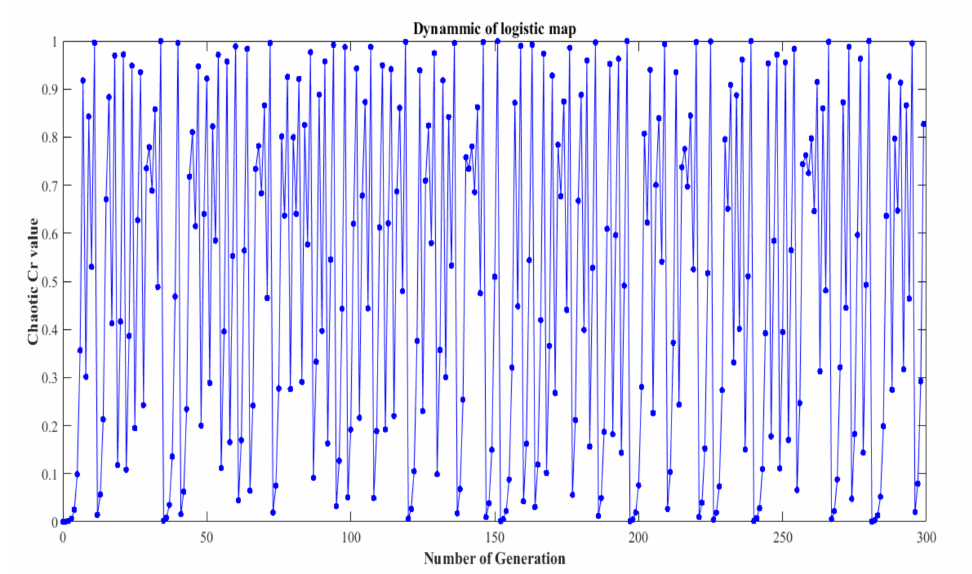
Figure 1. Chaotic Cr value using a logic map.